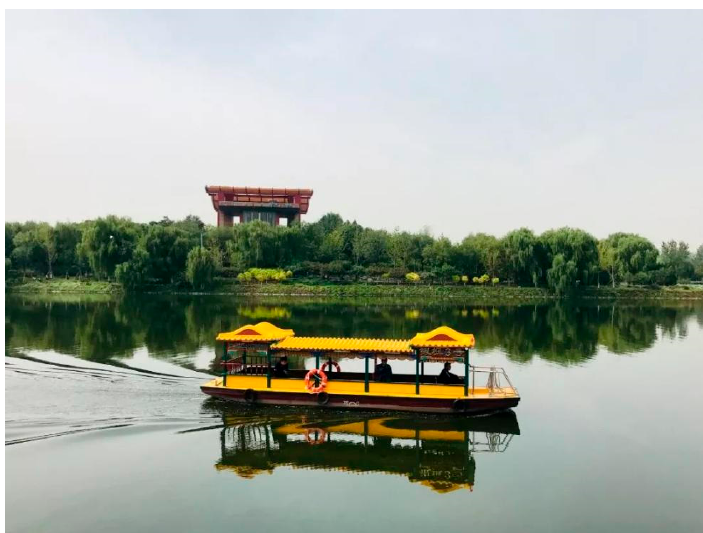
Figure 9. Canal navigation of the North Canal in Beijing at Tongzhou section of the Beiguan sluice en route to the Gantangzha sluice).